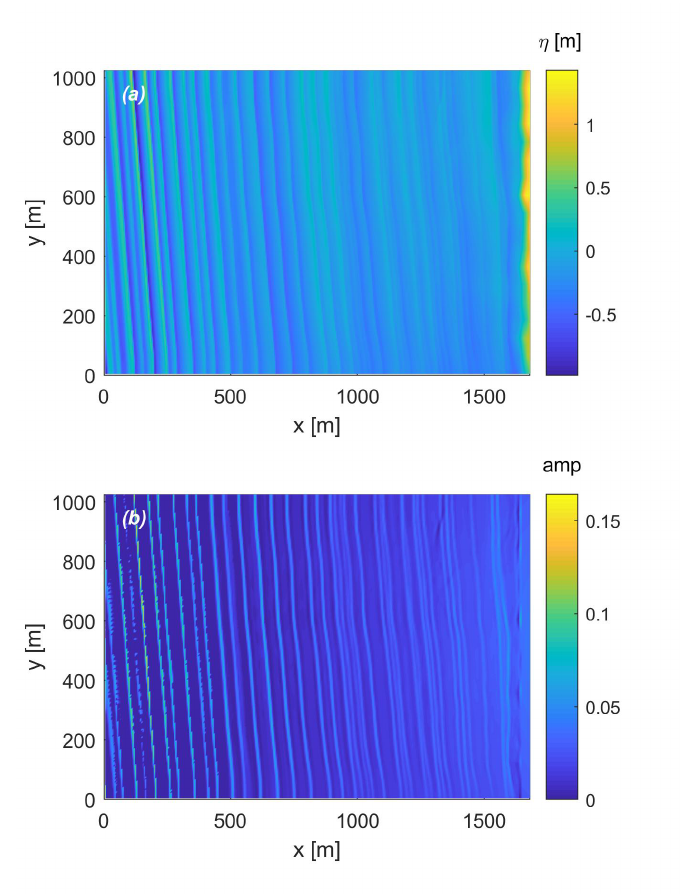
Figure 4. ( a ) Synthetic sea-wave image obtained from the NSWE solver. ( b ) Simulated radar